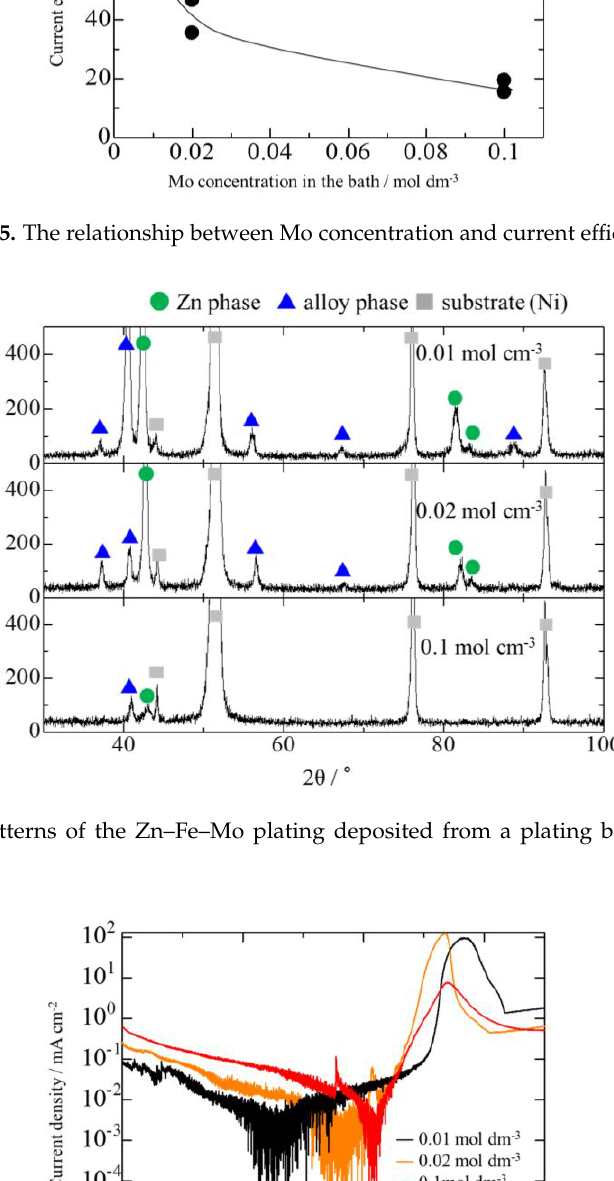
Coatings 2017 , 7 , 235 11 of 13